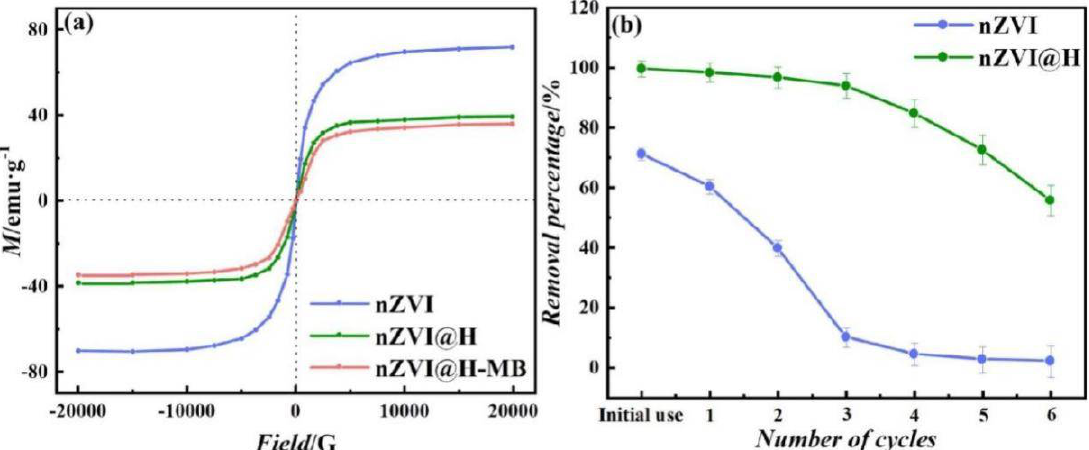
Figure 11 . ( a ) VSM of nZVI, nZVI@H and nZVI@H-MB; ( b ) reusability of nZVI@H in MB removal. Figure 11. ( a ) VSM of nZVI, nZVI@H and nZVI@H-MB; ( b ) reusability of nZVI@H in MB